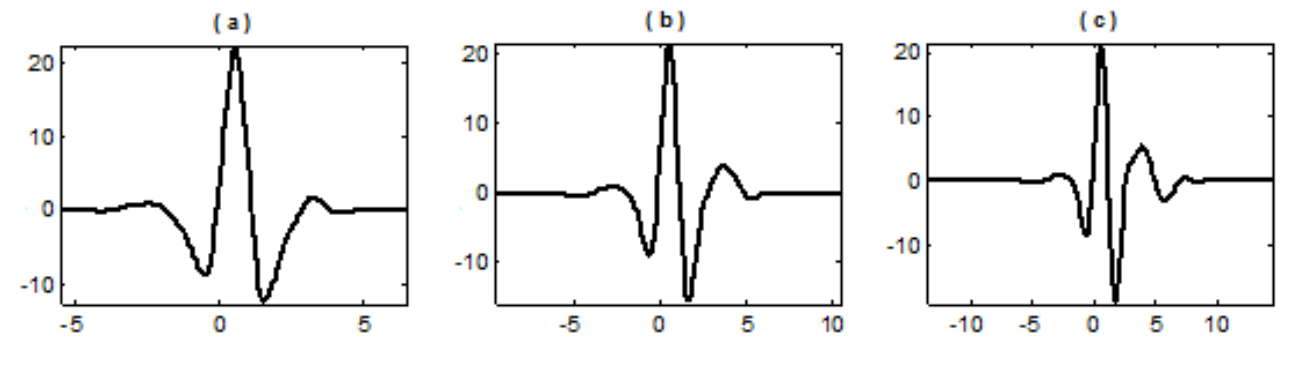
Figure 2. Wavelet constructed with basis function (2) and different selection of ( M , N ): ( a ) when ( M , N ) = (4,3); ( b ) when ( M , N ) = (6,5); ( c ) when ( M , N ) =